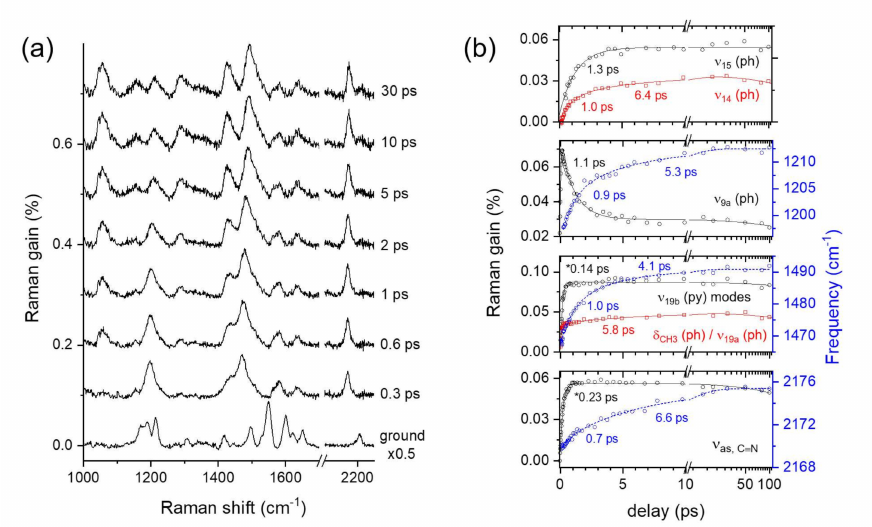
Figure 2. ( a ) Femtosecond stimulated Raman spectra of DCM in DMSO solution with 403 nm excitation and ( b ) the population and structural dynamics of major vibrational modes: ν 15 (ph) and ν 14 (ph) at 1057 and 1288 cm − 1 ; ν 9a (ph) at 1200–1212 cm − 1 ; ν 19b (py) modes at 1471–1492 cm − 1 and δ CH3 (ph) or − 1 ; and ν − 1 . All the kinetic traces were fit with a ν 19a (ph) mode at 1436–1428 cm as,C ≡ N at 2170–2175 cm number of exponential functions convoluted with a Gaussian function for the instrument response function of the experiment. Solid and dotted lines represent the fit results for the population and structural dynamics, respectively. The “ph” and “py” denote the phenyl and pyran ring,